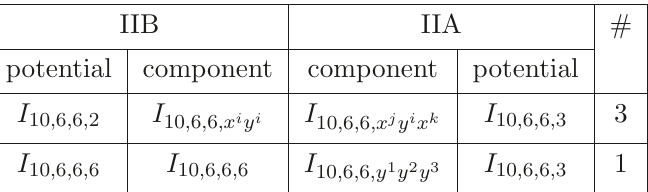
Table 6 . The α = − 7 branes that can be included in order to cancel the tadpoles generated by the NS ′ and RR ′ fluxes. In order to avoid cumbersome notations, in all terms we have not specified the sets of ten and six internal indices. In the last column we give the number of independent components for each potential, which corresponds to the number of different branes, which are 4 in